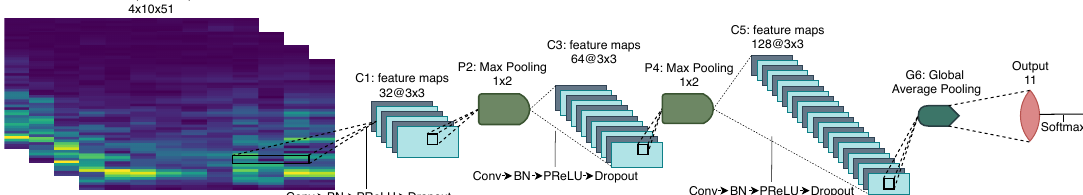
Figure 10. The Spectrogram ConvNet architecture employing 95,627 parameters. In this figure, Conv refers to Convolution and BN refers to Batch Normalization. The input represented comes from the 3DC Armband with the channels on the x -axis and the frequency bins on the y -axis. Due to the Myo Armband associated input size, P4 and C5 were removed from the architecture when training on Myo’s